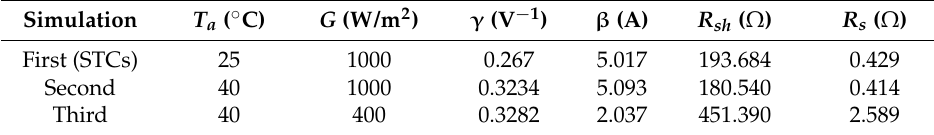
Table 2. Calculated values of the photo-voltaic (PV) module in Table 1.